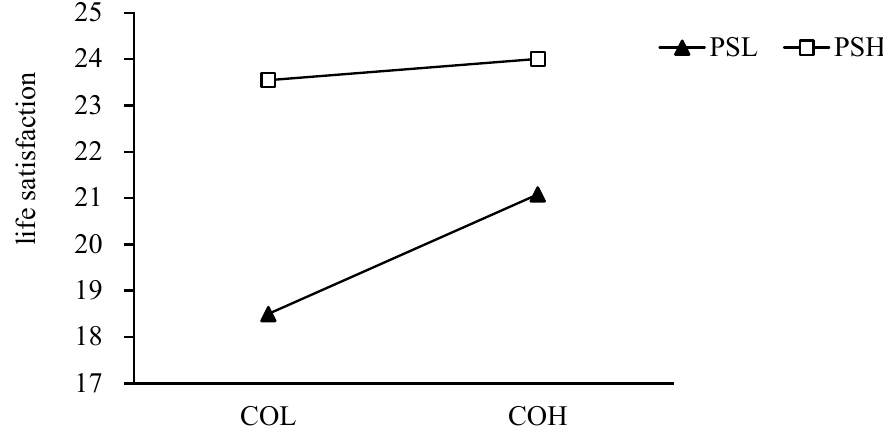
Figure 2. The moderating effect of perfectionistic strivings on the relationship between perceived control and life satisfaction. COL: low perceived control, NH: high low perceived control, PSL: low perfectionistic strivings, and PSH: high perfectionistic strivings.